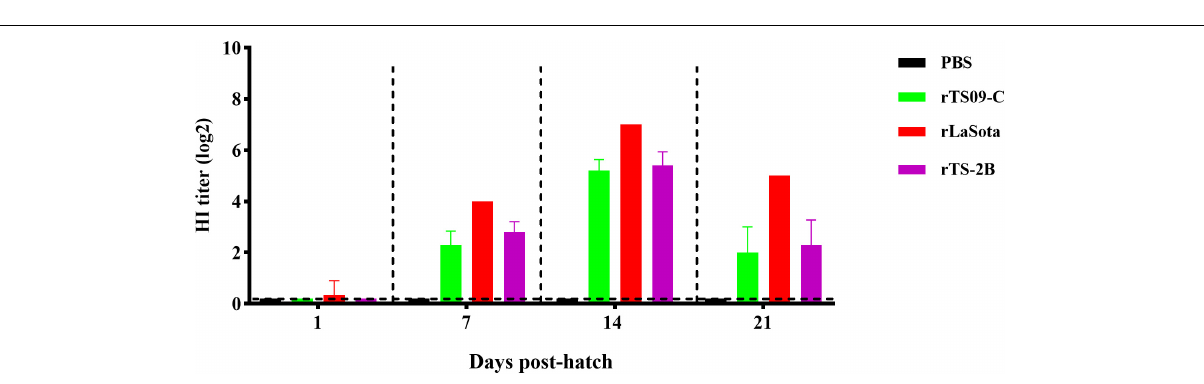
MDT = 108 h), and rTS-a was similar to its parental strain rTS09- C (ICPI = 0.00 and MDT > 168 h). The pathogenicity of chimeric virus rTS-2B (ICPI = 0.15 and MDT = 112 h) was similar to that of strain LaSota, but not to that of TS09-C. The amino acid mutation R115G was located at the Fcs. These results imply that Fcs is the crucial attenuation determinant of TS09-C in chicken